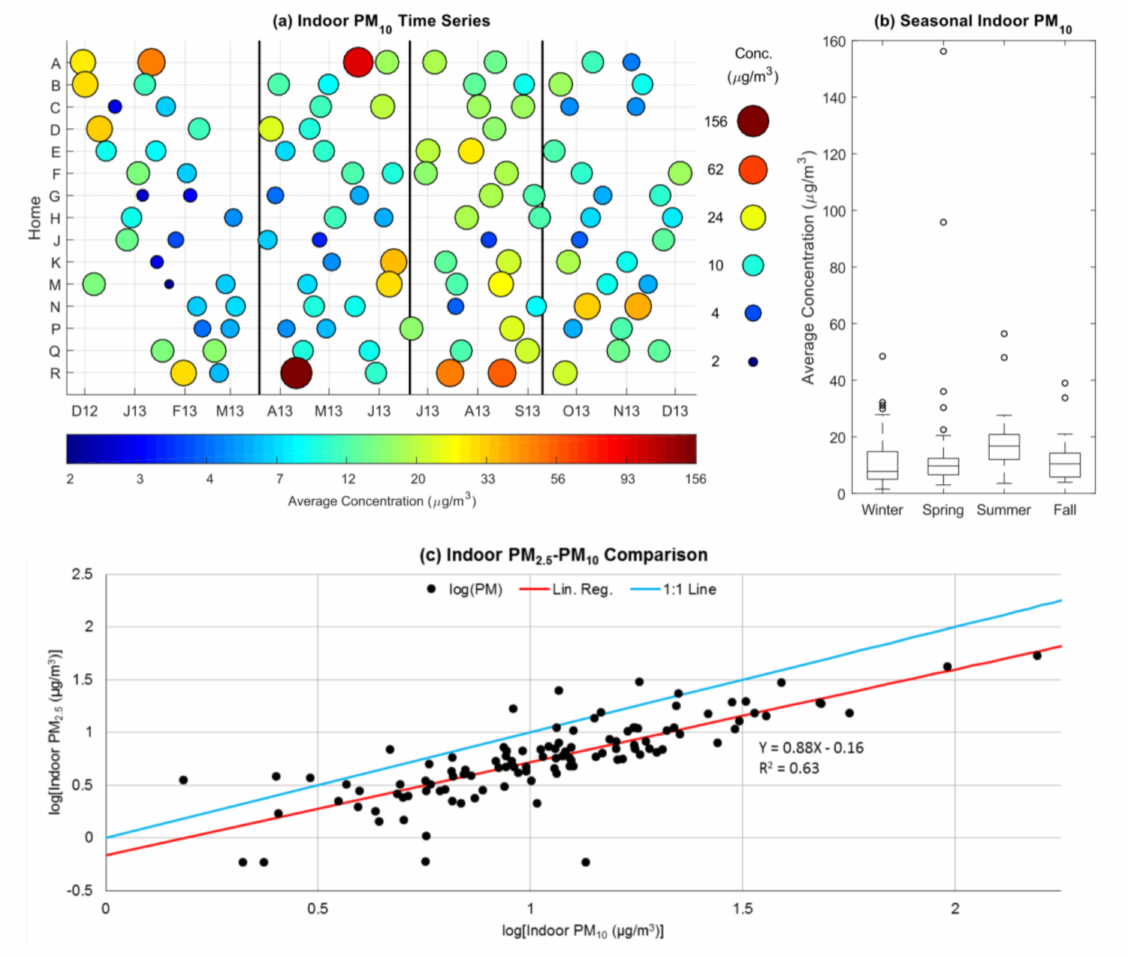
Figure 4. ( a ) Average indoor PM 10 concentrations (color and marker size are on a logarithmic scale and indicate PM 10 concentrations; vertical bars separate seasons); ( b ) seasonal box plots of average indoor PM 10 concentrations; and ( c ) scatter plot and linear regression between indoor PM 10 and PM 2.5